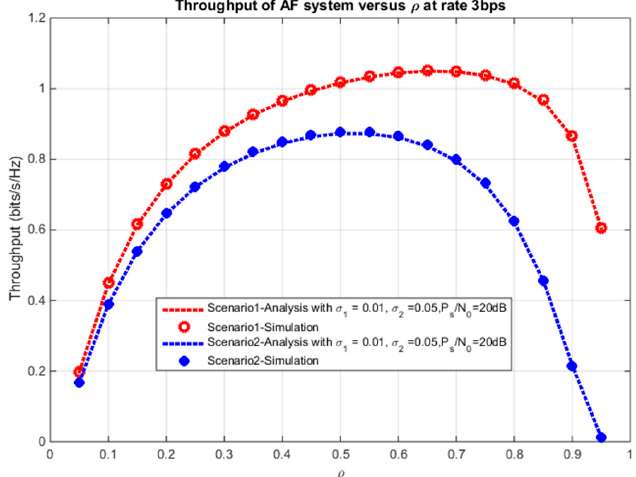
Figure 8. The throughput versus ρ for the PS protocol.